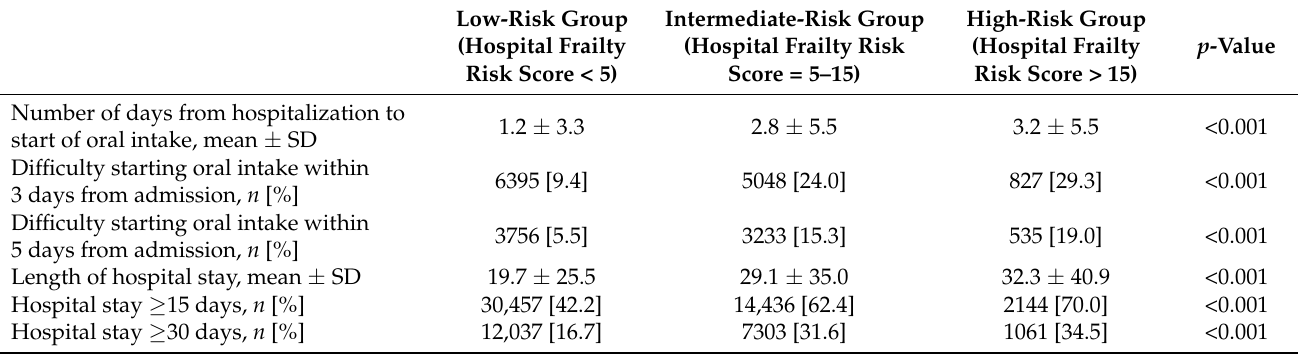
Table 2. Comparison of Hospital Frailty Risk Score and outcomes between groups.